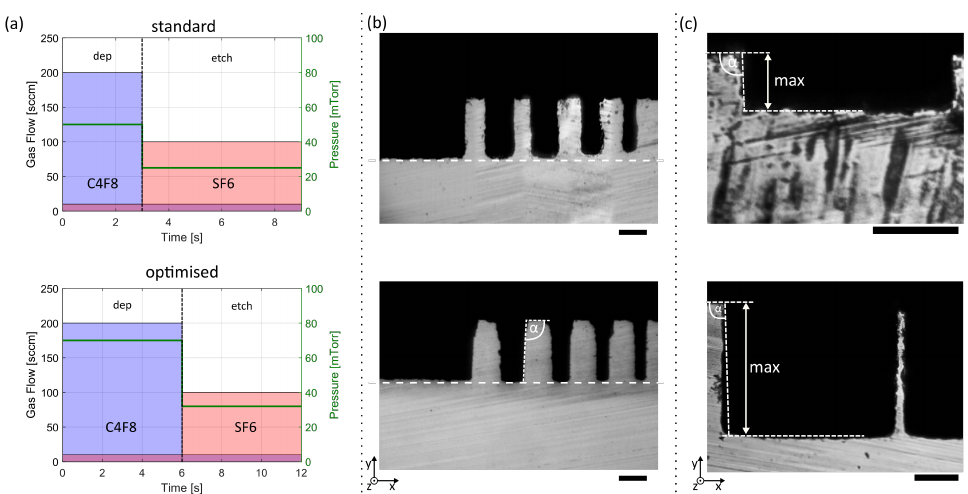
Figure 2. Reduced RIE lag. ( a ) Schematic of the Bosch process parameters for a standard process ( top ) and the optimised process parameters ( bottom ). A minimum gas flow of 10 sccm is always main- tained to enable faster switching times (violet horizontal bar). ( b ) Optical microscopy images of diced silicon wafers to illustrate the improvement in RIE lag. ( top ) Trenches etched with the standard Bosch process, with 20µm to 5µm wide trenches reached a depths of 38.8µm and 34.6µm, respectively, corresponding to an RIE lag of 10.8%. ( bottom ) Trenches etched with our optimised process, with 20µm to 5µm width were etched 47.8 ± 1.9µm deep into the silicon wafer, corresponding to a RIE lag of below 1.5%. The optimised process lead to an etch angle of α = 91.1° ± 0.6° (see Supporting Figure S3). Scale bars corresponding to 20µm. ( c ) Optical microscopy images of a diced silicon wafer with a 200µm wide trench. The maximal achievable etch depth with 1.4µm PR ( top ) and 2µm SiO 2 ( bottom ) as the mask was 29µm and 141µm, respectively. Scale bars corresponding to